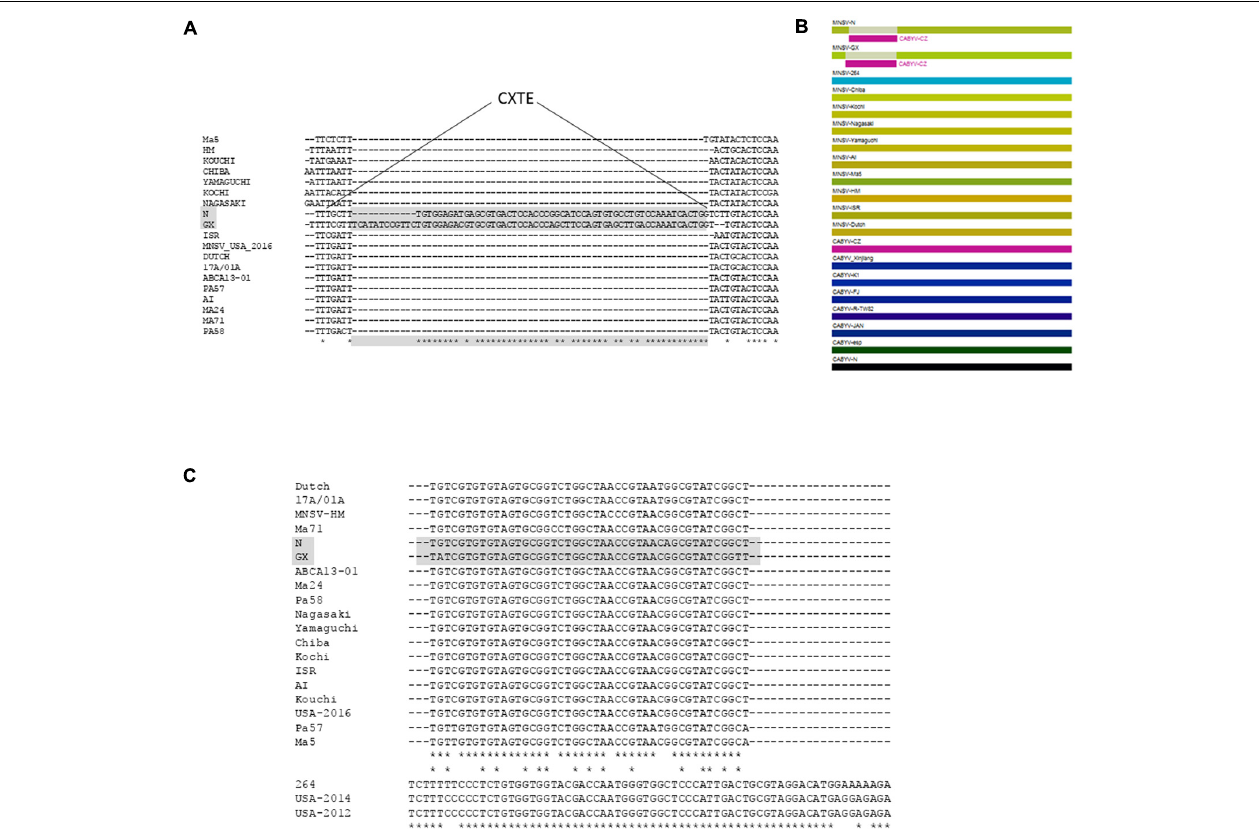
FIGURE 5 | New 3 (cid:48) -CITEs acquired by MNSV isolates through recombination. (A) Sequence alignment of the 5 (cid:48) -end of the 3 (cid:48) -UTR of MNSV isolates. GenBank accession numbers of MNSV sequences included in the alignment are Ma5-AY122286, HM-GU480022.1, Chiba-AB250684, Yamaguchi-AB250687, Nagasaki-AB250686, Al-DQ339157, Dutch-NC001504, ISR (Israel)-DQ922807, Kochi-AB250685, Kouchi-AB189943, Ma24-EU589616, Ma71-EU589619, Pa58-EU589620, Pa57-EU589621, 17A/01A-M29671, ABCA13-01-KR094068, USA-2016-KY124137, N- KF060715, GX-KY264755. The inserted sequence is marked in gray. Asterisks mark conserved nucleotides of all sequences or in gray of the insertions. (B) Proposed recombination event generated by the RDP4 software, a computer program for characterizing recombination events in sequence alignments using several different recombination analysis methods and tests for recombination hot-spots. The sequences included in this analysis are the 3 (cid:48) -UTRs of MNSV [see part (A) of this figure] and CABYV isolates [GenBank accession numbers are CABYV-Xinjiang: EU636992; CABYV-Beijing: EU000535; CABYV esp (JF939814), CABYV-N (NC_003688), CABYV-K1 (LC082306), CABYV-FJ: GQ221223; CABYV-JAN: GQ221224; CABYV-R_TW82: JQ700306]. RDP4 colors similar sequences with similar colors. The statistical significance is very high, with a P -value < 0.001. (A,B) Of this Figure is based on our data derived from Miras et al. (2014). (C) Sequence alignment of the 3 (cid:48) -CITEs of MNSV isolates. GenBank accession numbers as above, plus MNSV-264 (AY330700), USA12 (KY124136), USA14 (KY124135), based on our data derived from Truniger et al. (2008). In the middle, the upper line with asterisks marks conserved nucleotides between sequences above; the lower asterisks line marks conservation between upper and